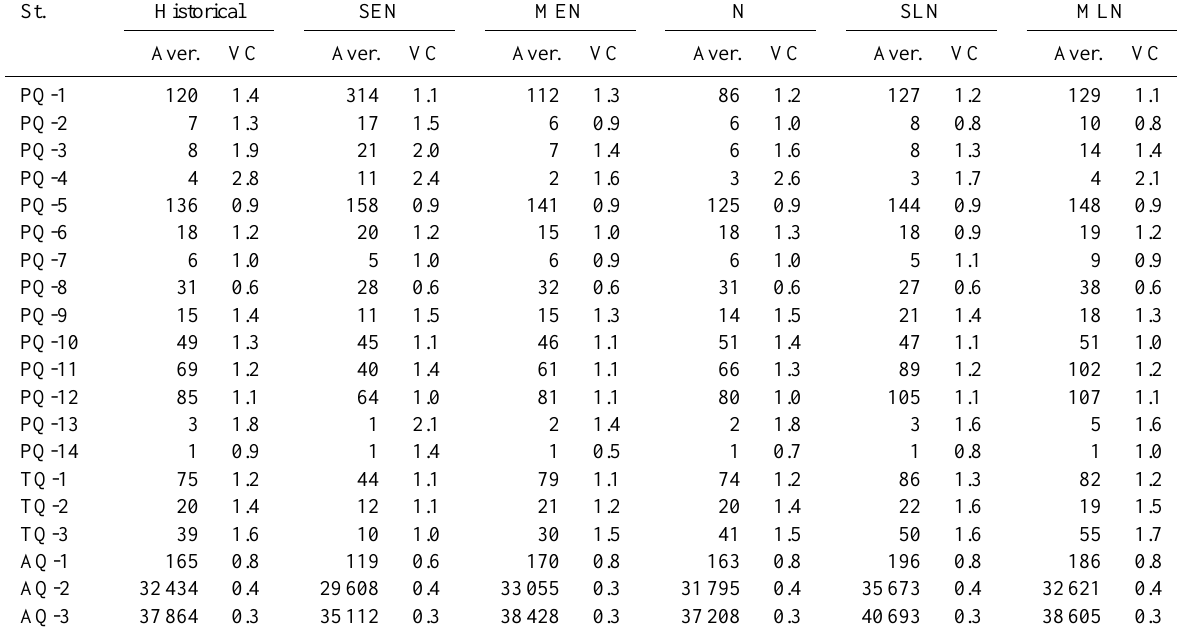
Table 2. Monthly statistical values for the discharges during the different periods: St.: Stations; Aver.: Average; VC: Variations Coefficient. St.